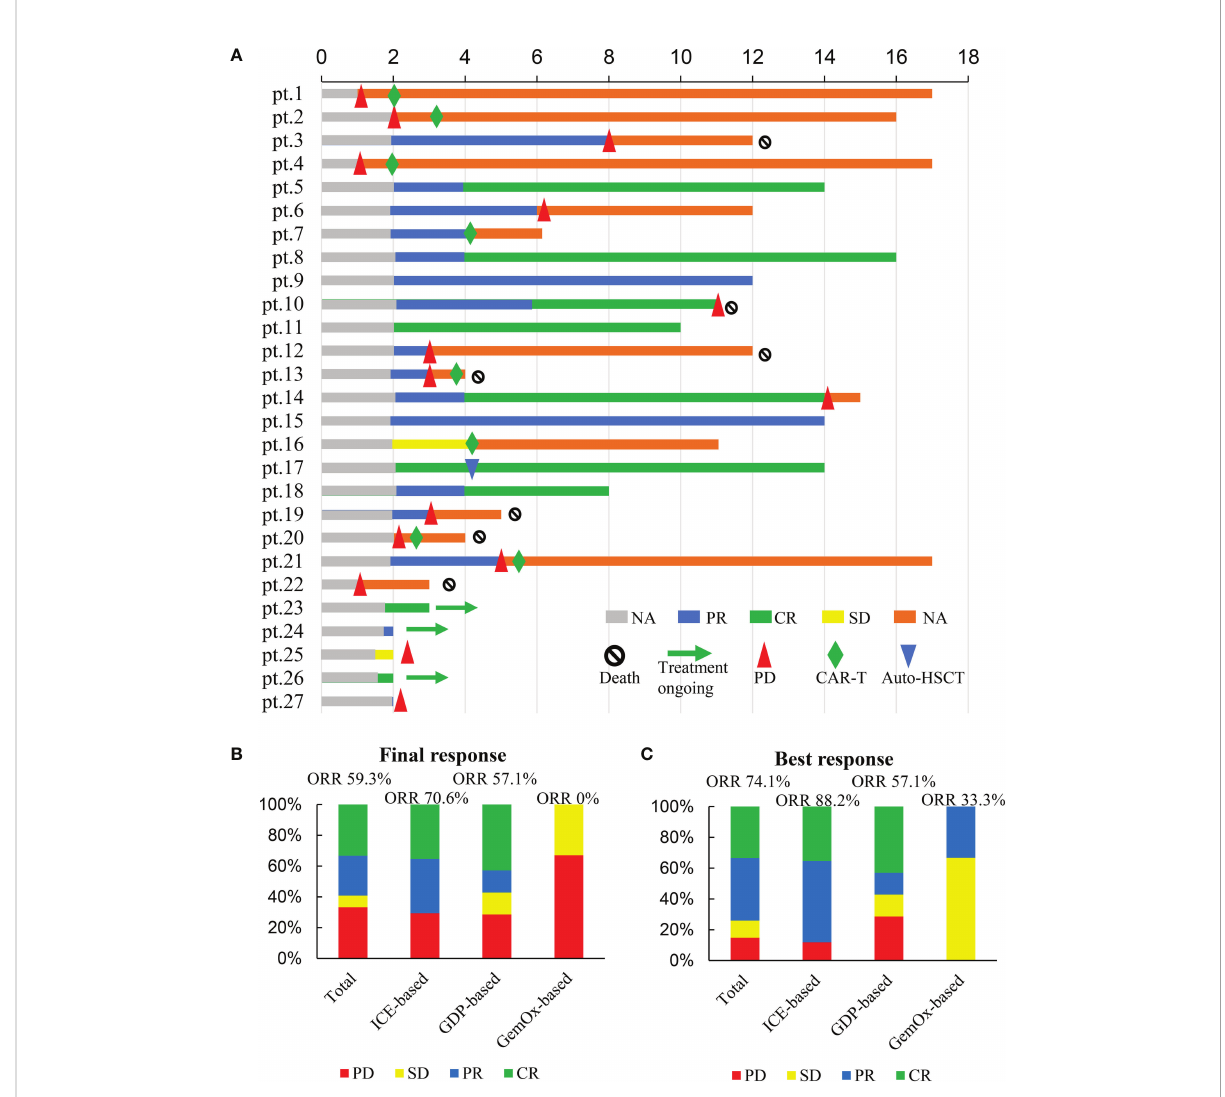
FIGURE 1 Responses to treatment. (A) swimmer plots of all patients evaluable for response; (B) Final responses to treatment; (C) Best responses to